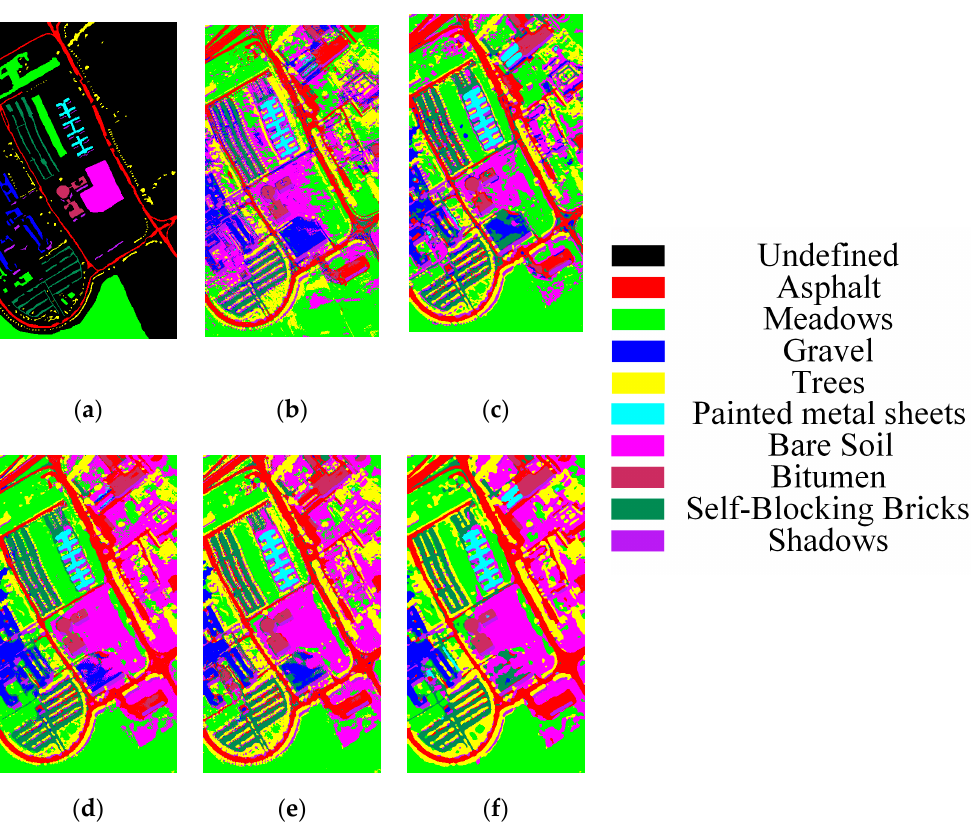
Figure 10. Classification maps for University of Pavia dataset: ( a ) Ground-truth map, ( b ) SSLSTMs, OA = 83.36%, ( c ) 3D CNN, OA = 91.71%, ( d ) FDSSC, OA = 98.39%, ( e ) SSRN, OA = 99.12%, ( f ) SSCC, OA = 99.71%.